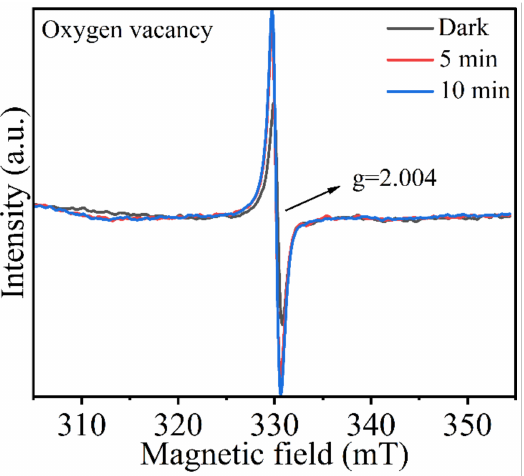
Figure 5. ( a ) XPS survey spectra and high-resolution XPS spectra of ( b ) Mn 2p, ( c ) I 3d, ( d ) Bi 4f, and ( e ) O 1s for α -MnO 2 , BiOI, and MBI2 composites (The colored lines represent the fitted curves, blue for O 1s, red for O L , green for O V and purple for − OH).